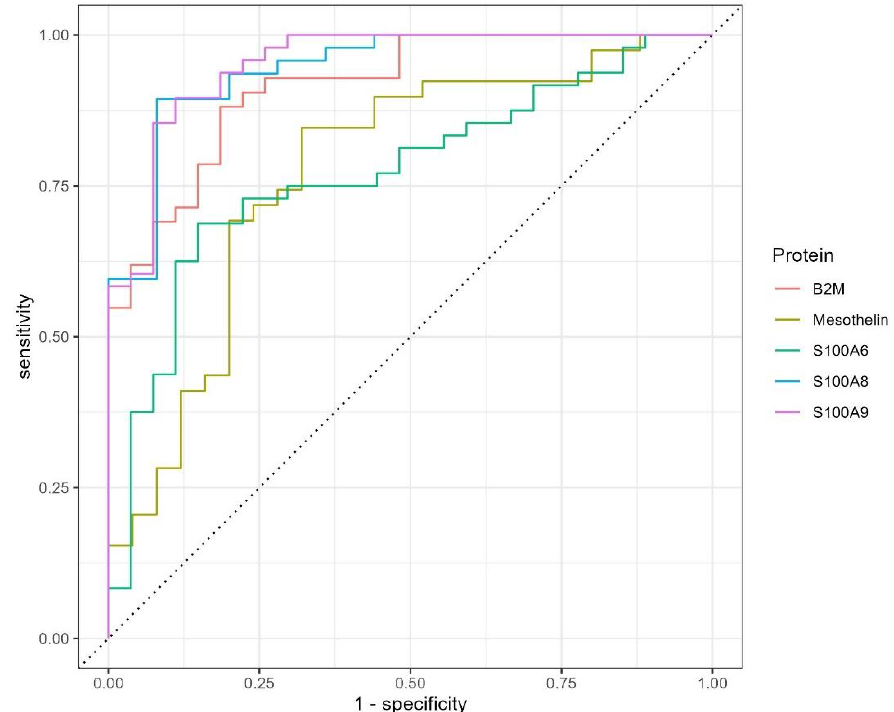
Figure 5. Receiver operating characteristic (ROC) plot of the area under the curve (AUC) for the most altered proteins found in the studied cohort and credibly associated with the CRVO pathology and the caused ischemic condition. The ROC curves have been plotted for S100A9 (AUC = 0.952), S100A8 (AUC = 0.945), B2M (AUC = 0.915), MSLN (AUC = 0.775), and S100A6 (AUC = 0.772).